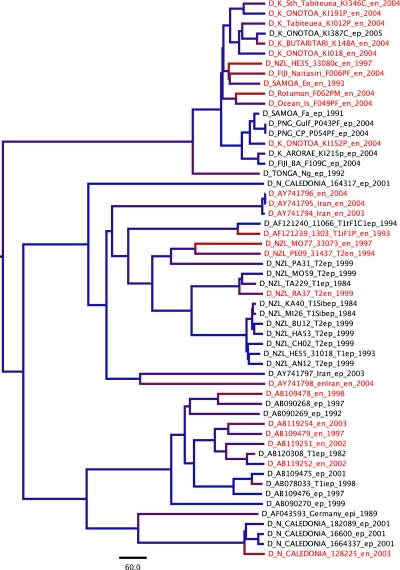
Maximum clade credibility (MCC) resulting from the analysis of the Genotype D between-host data set. Colors along the branches indicate relative rates, from a scale of blue (the most slowly-evolving branches) to red (the most rapidly-evolving branches). Taxon labels of the most rapidly evolving branches are highlighted in red.